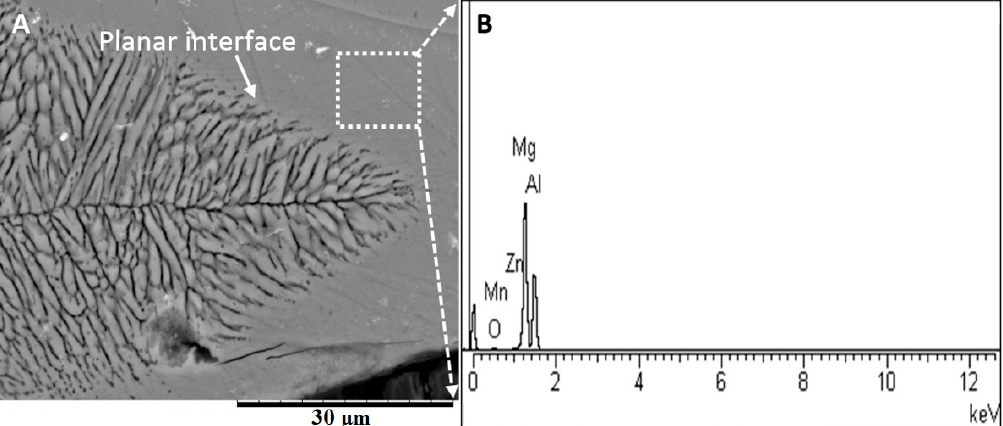
Figure 5. ( A ) Microstructure of the Al weld interface showing the growth of columnar grains; ( B ) EDS analysis of the Al fusion interface.